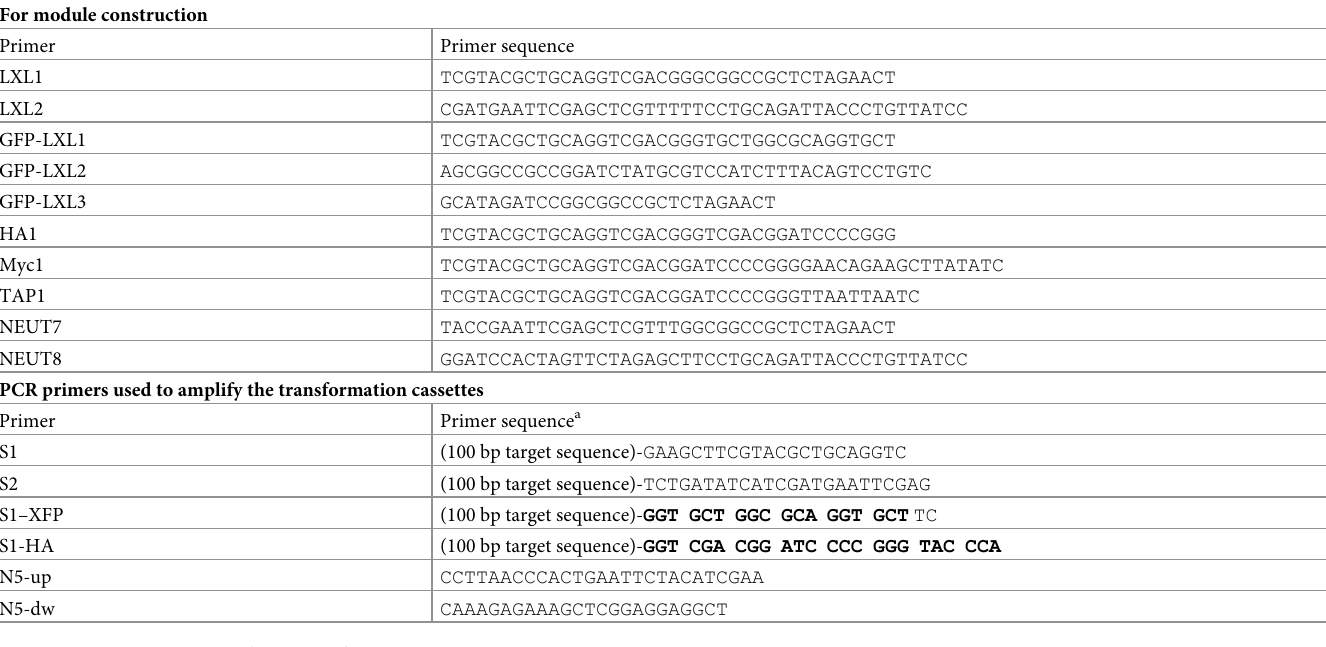
Table 2. Primers